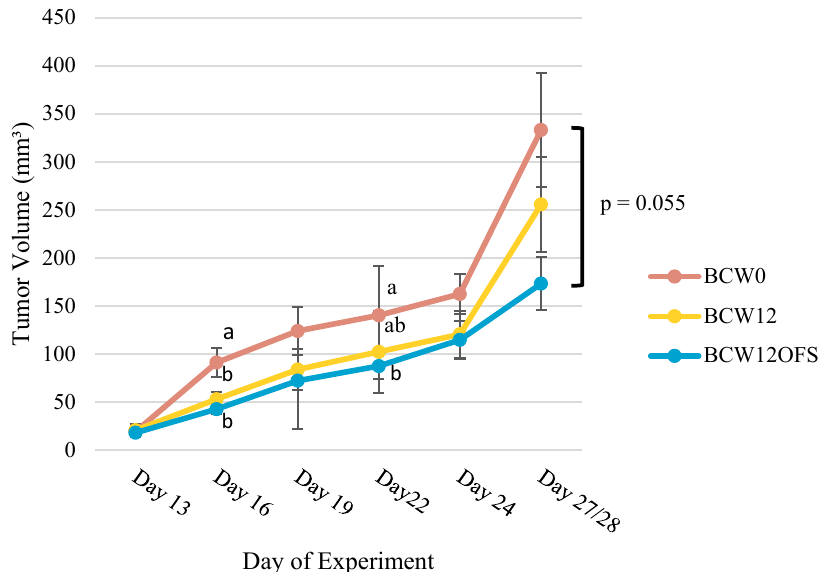
Figure 7. Tumor volume over time. Average tumor volume at each measurement time point is plotted for each group. BCW0 ( n = 10), BCW12 ( n = 12), BCW12OFS ( n = 12). Average volume differed significantly between groups on day 16 and day 22. Values without a common superscript are significantly different ( p < 0.05; i.e., ‘a’ is different from ‘b’ but ‘ab’ is not different from ‘a’ or ‘b’). Data are presented as mean ± SEM.